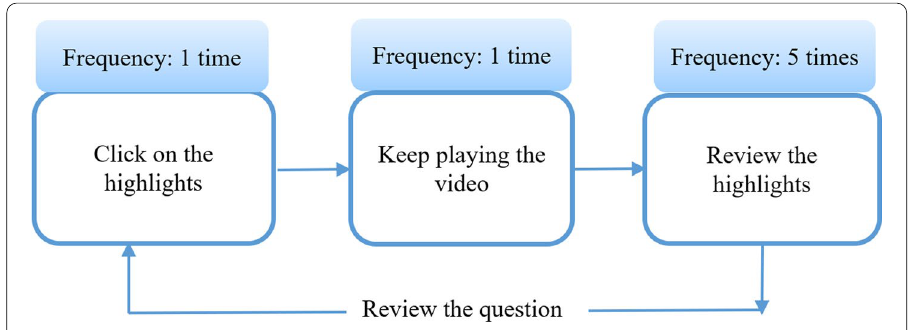
Fig. 5 S9 ′ s learning path prompted by the teacher’s